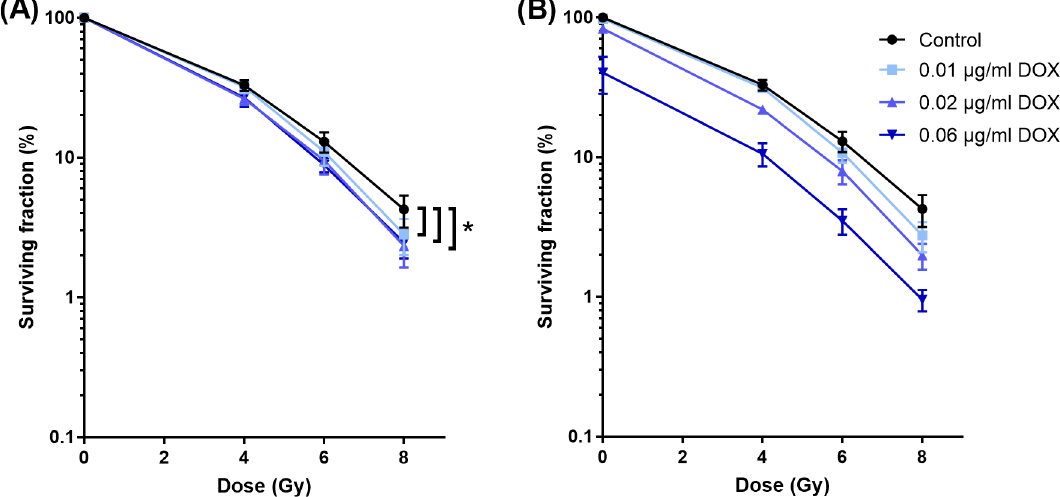
Fig 2. Cytotoxicity of DOX at different concentrations and RT. Surviving fraction as function of radiation dose for different DOX concentrations. Cells were exposed for 1 hour to DOX (0.01, 0.02 or 0.06 μg/mL) before RT. Surviving fraction calculated by samples treated with the corresponding DOX concentration (A) or by untreated sample (B). All DOX concentrations resulted in a significant enhancement of RT. In addition, 0.06 μg/ml DOX resulted in a larger RT effect compared to 0.01 μg/ml DOX (p < 0.05).